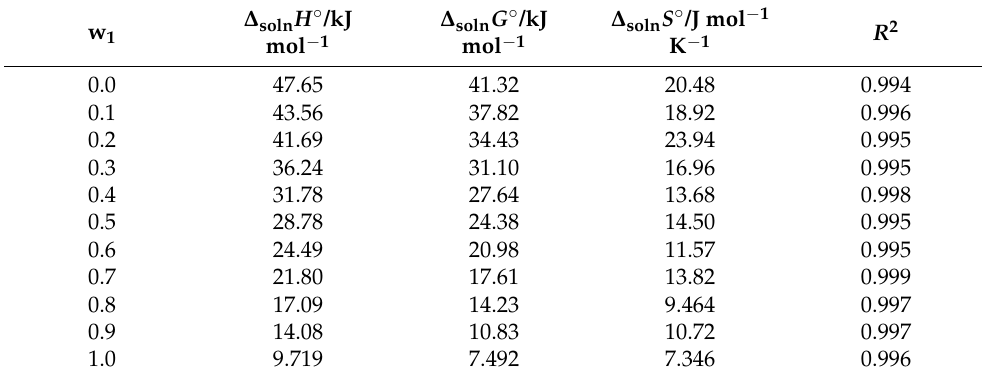
Table 5. Apparent standard enthalpy ( ∆ soln H ◦ ), apparent standard Gibbs energy ( ∆ soln G ◦ ), apparent standard entropy ( ∆ soln S ◦ ), and van’t Hoff R 2 values for CNZ (3) in different {TP (1) + water (2)} combinations at T hm = 303.0 K a .